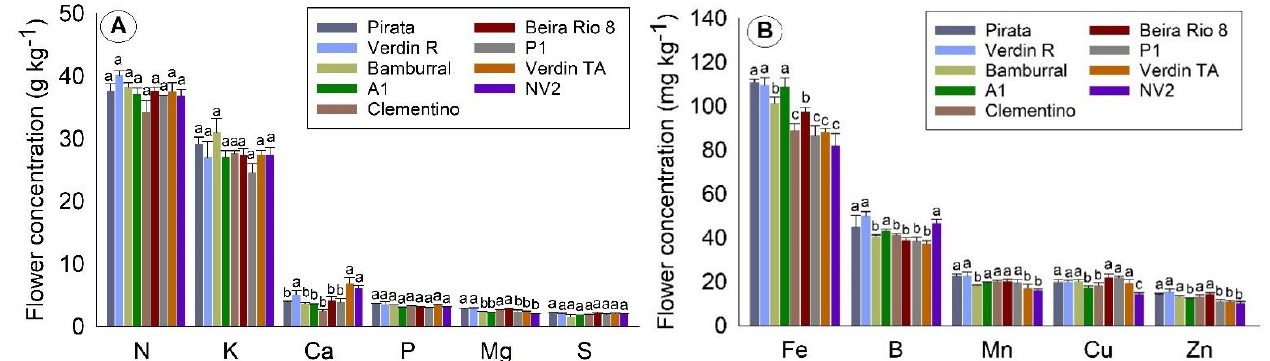
Figure 1. Concentration of macronutrients ( A ) and micronutrients ( B ) in flowers of nine Coffea canephora genotypes. São Mateus, state of Espírito Santo — Brazil. Means followed by the same letter for each nutrient do not differ by the Skott–Knot test at 5% probability.